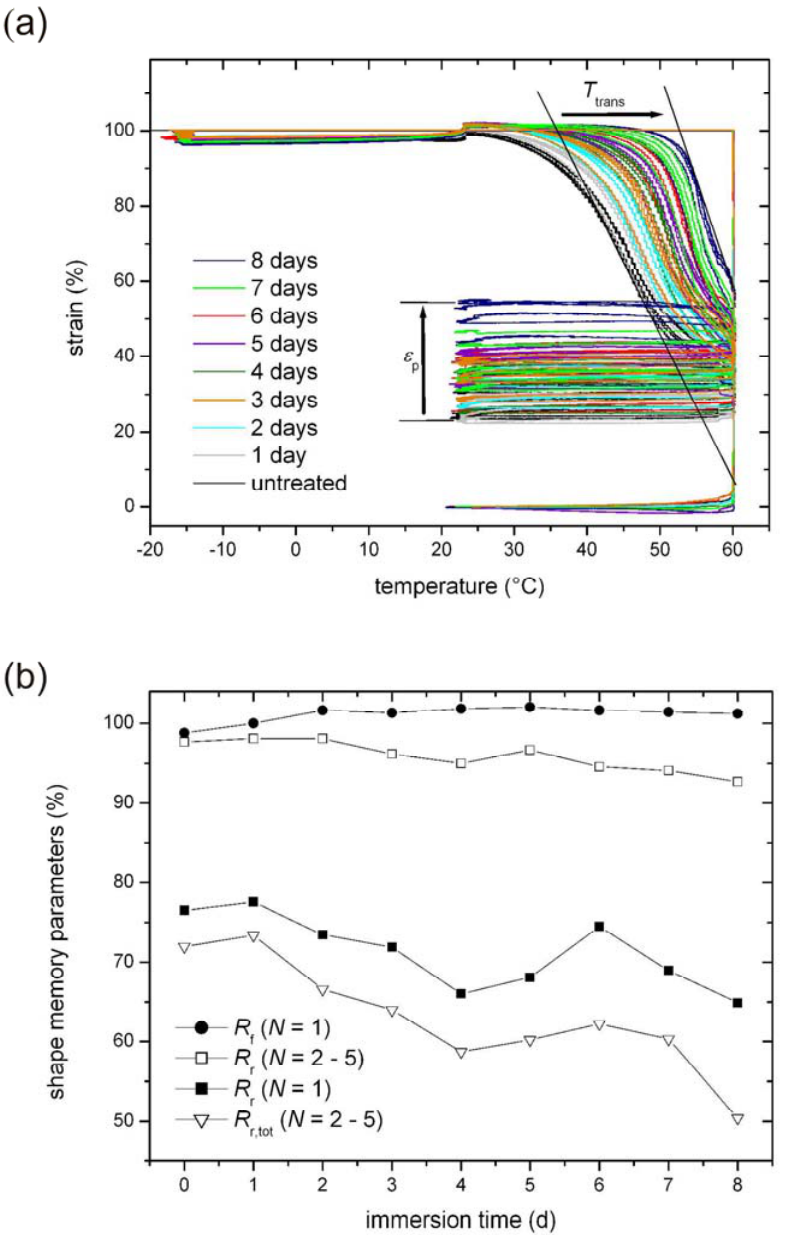
Figure 4. Effect of hydrolysis (80 °C) on the cyclic thermo-mechanical properties of PBA-based SMPU (maximum strain ε protocols, in which arrows are used to point out aging trends regarding T against immersion time. Reprinted with permission from [227] (© 2009,